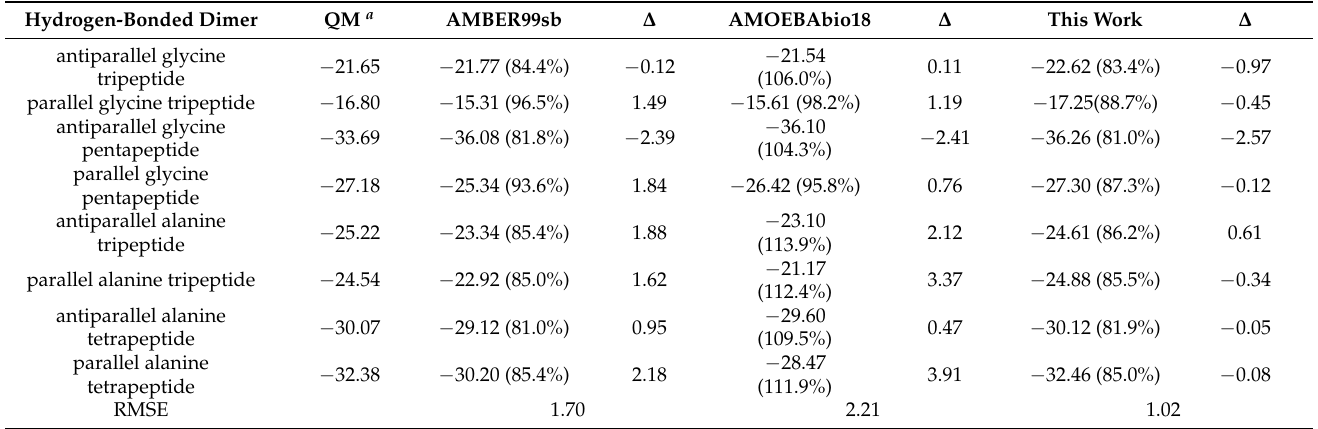
Table 4. Interaction energies (kcal/mol) for hydrogen-bonded dimers.